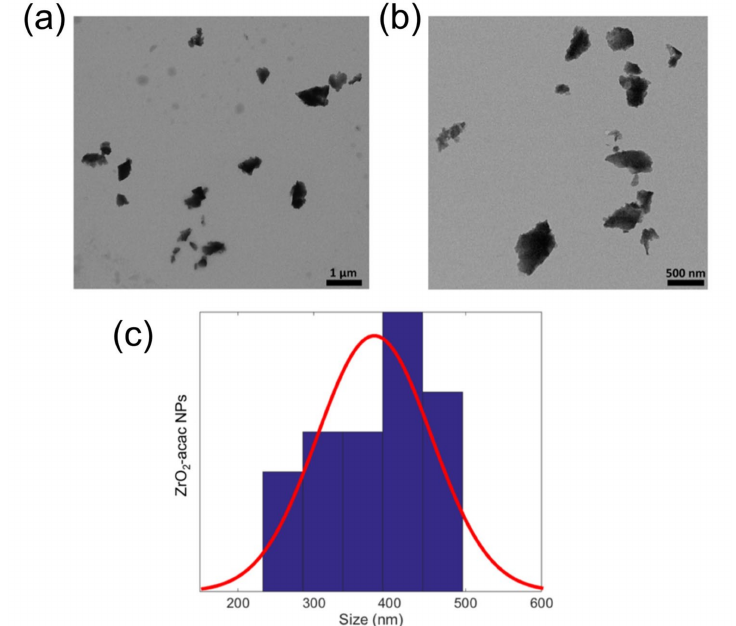
Figure 1. ( a , b ) TEM images of the ZrO 2 -acac NPs acquired with two different magnifications. ( c ) TEM size distribution and Gaussian fit.